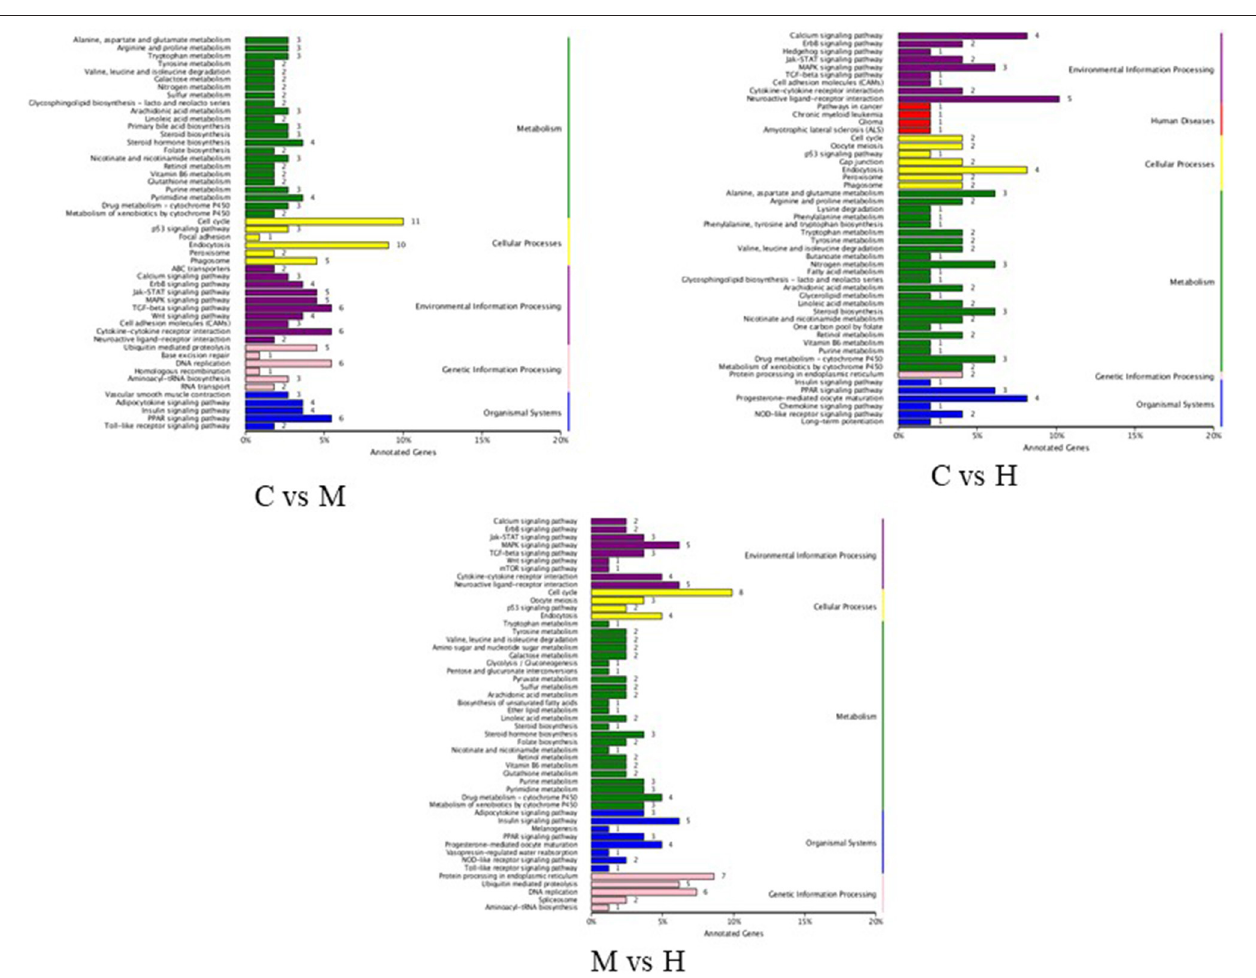
FIGURE 4 | KEGG functional classification of DEGs.